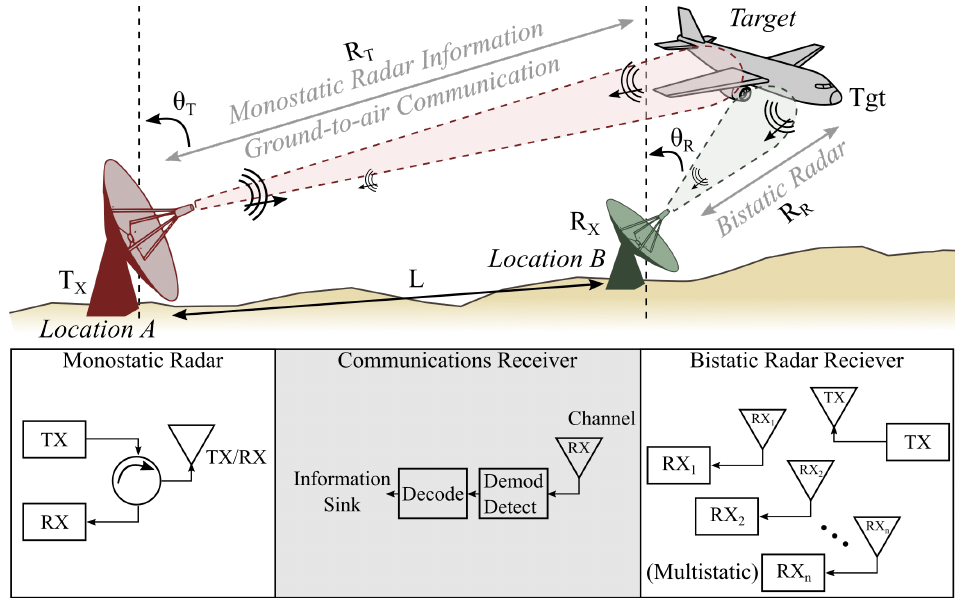
Figure 3. Illustration of the joint radar-communication systems.